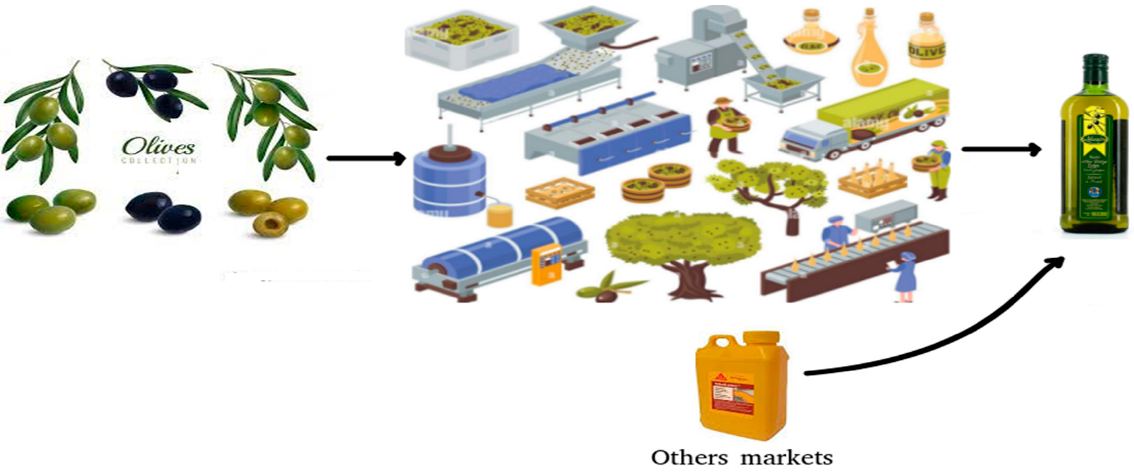
Figure 1. Fraud in transformation process.